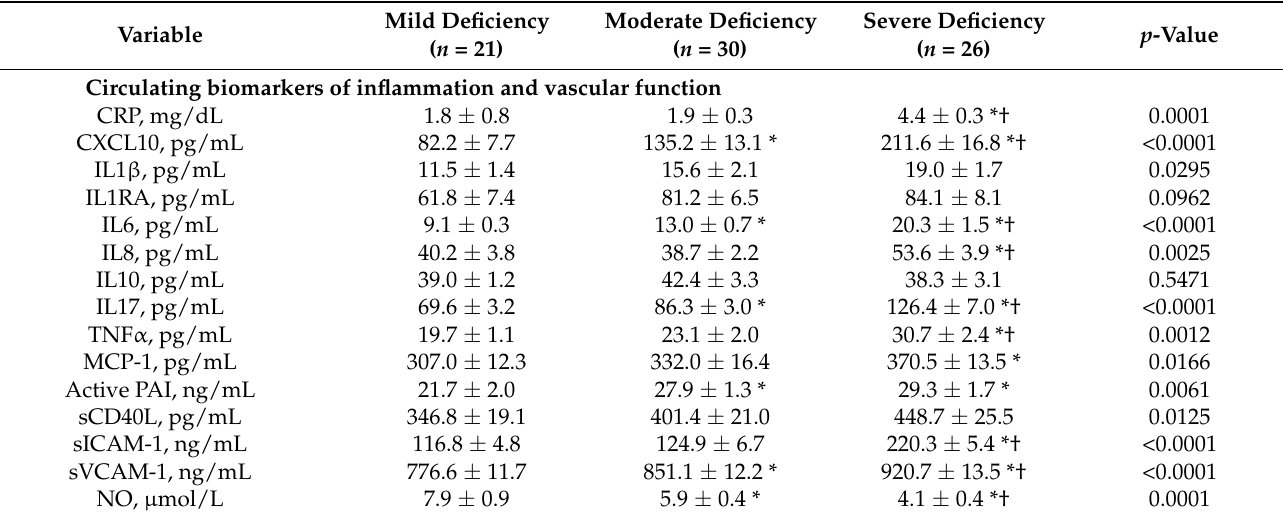
and acute-phase proteins were found to be the highest in the subjects with a severe VD deficiency. Nitric oxide (NO) levels in the blood were also determined by measuring ni- trates and nitrites and were found to be significantly lower in the higher VD deficiency categories (Table 3).